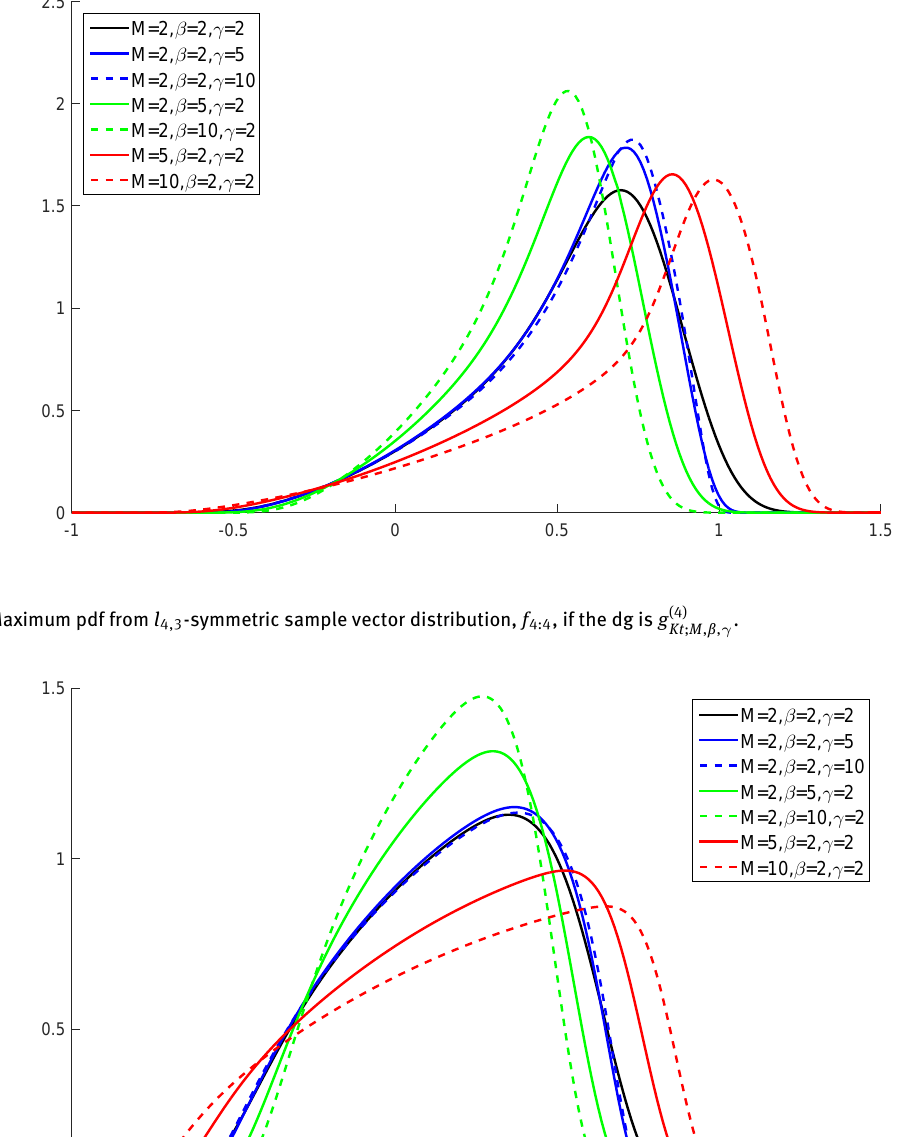
Figure 2: Pdf of the third order statistic from l 4,3 -symmetric sample vector distribution, f 3:4 , if the dg is g (4)